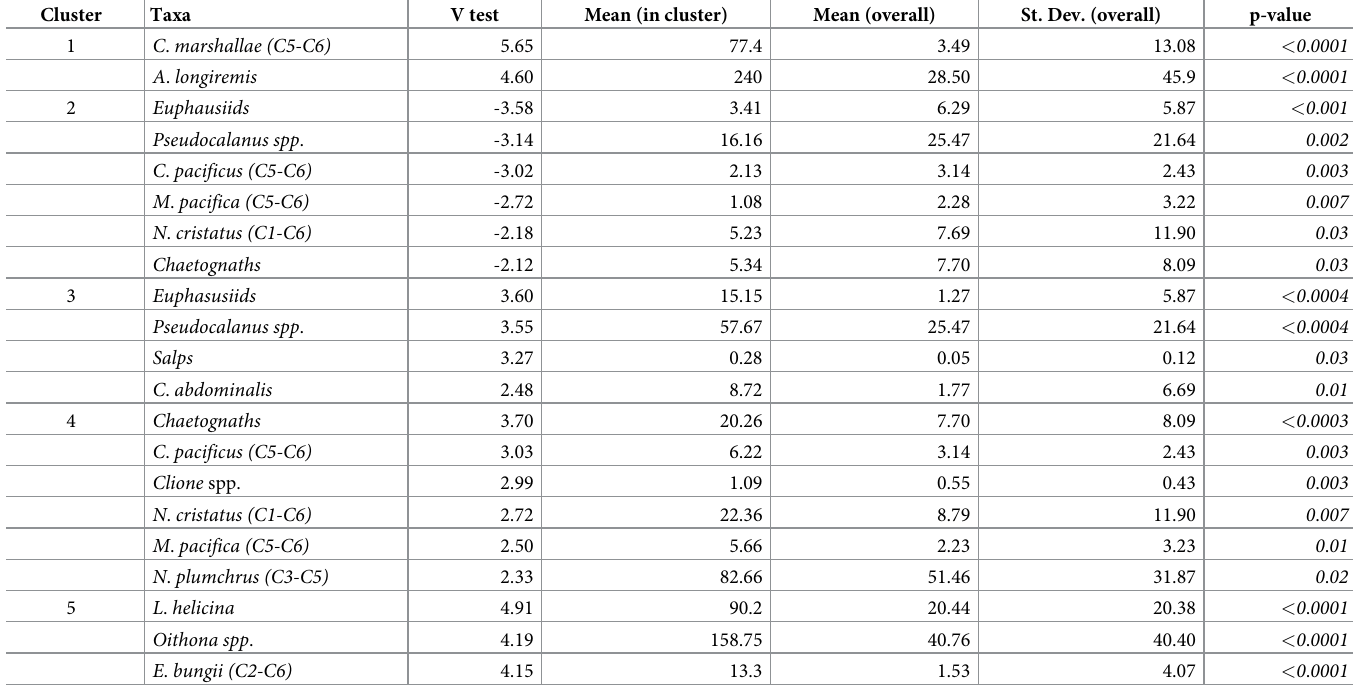
Table 2. Functional groups significantly associated with baseline spatial clusters.